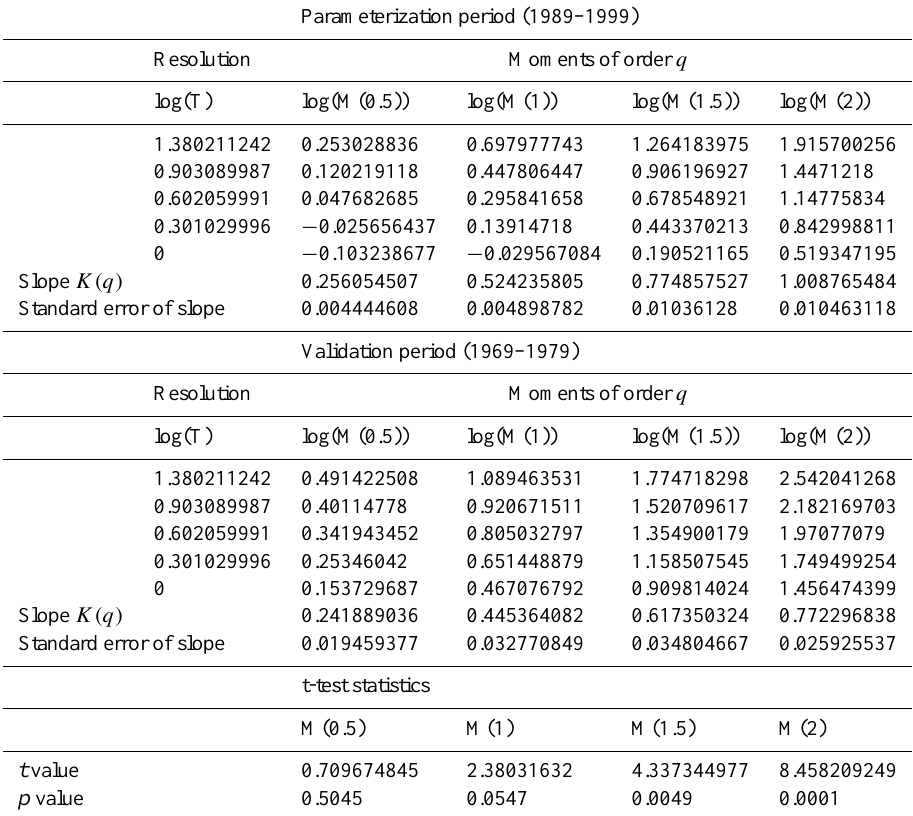
Table 2. Ordinary least squares estimation of scaling exponent K(q) from statistical moments of rainfall in the parameterization period (1989–1999) and validation period (1969–1979) with the corresponding standard errors. Statistics of a t-test for differences in slope between the moment-scale relationships of the two periods are given below for 6 degrees of